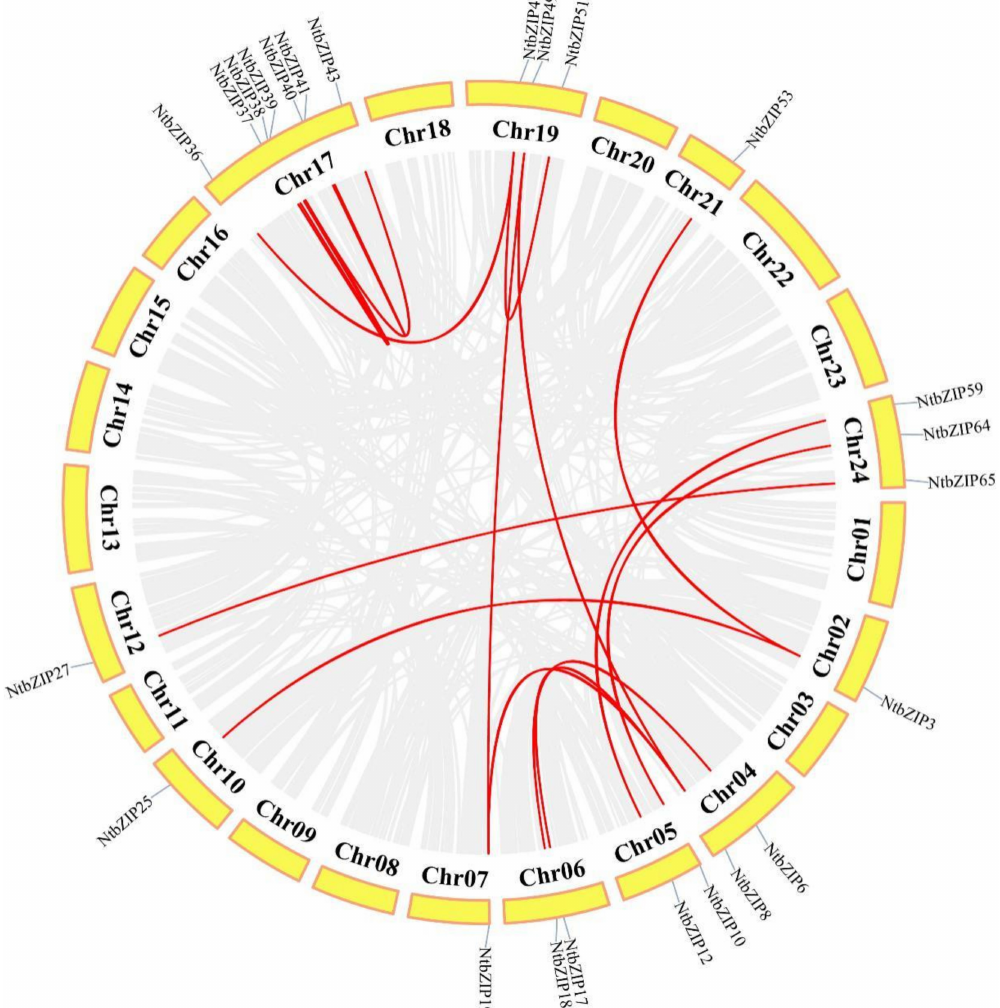
Figure 4. Segmental duplication analysis of the NtbZIP genes. The putative segmental duplication pairs in the tobacco genome are represented by the gray line, while the NtbZIP segmental duplication pairs are linked by the red